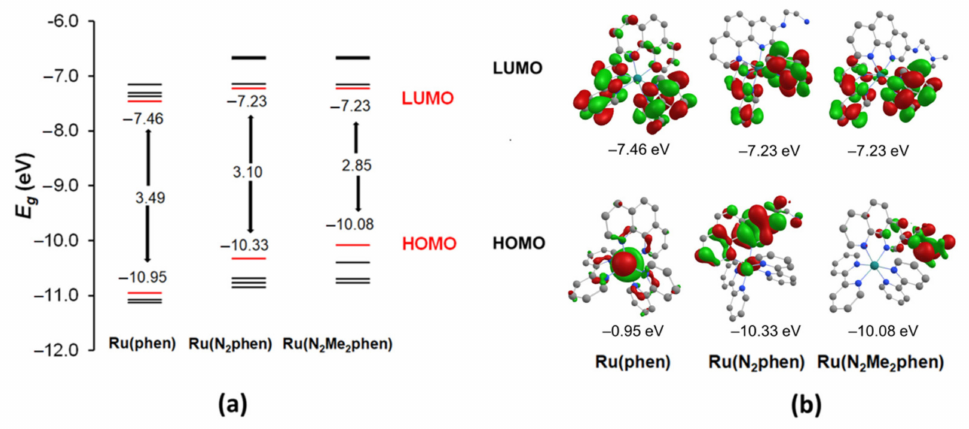
Figure 2. The schematic representation of the calculated energy levels in Ru(phen) , Ru(N 2 phen) , and Ru(N 2 Me 2 phen) ( a ) and isodensity plots of the HOMO and LUMO orbitals for these complexes ( b ). The DFT calculations with the Firefly quantum chemistry package [64], which is partially based on the GAMESS (US) [65] source code, were used to model the structure of the complexes. The B3LYP functional with the STO 6–31G(d,p) basis set was used in sis set and pseudopotential were employed [66]. The amidophosphonate fragment of Ru(N 2 P 2 phen) was replaced by a smaller methyl group and the corresponding complex was labeled Ru(N 2 Me 2 phen) . The optimized geometries of complexes Ru(N 2 phen) and Ru(N 2 Me 2 phen) are depicted in Figures S20 and S21 (see Supplementary Materials).